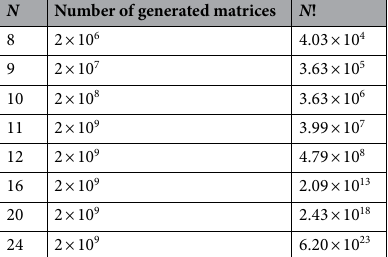
N Number of generated matrices N